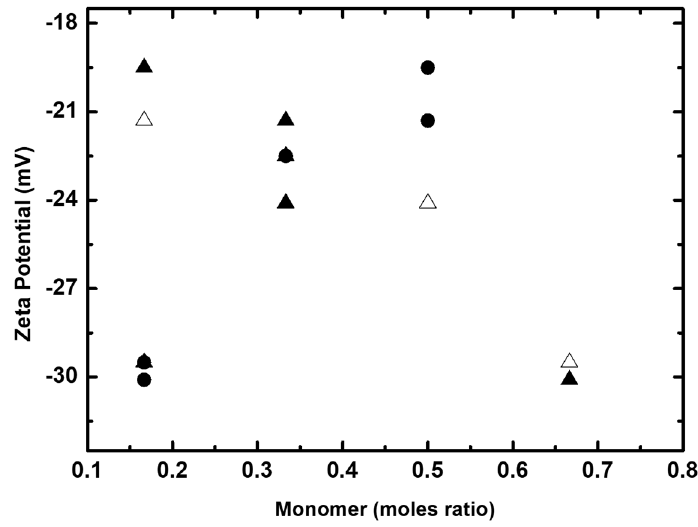
Figure 12. Zeta potential as function of moles ratio of BZMA ( Δ ), MMA ( ▲ ) and HPMA ( • ).